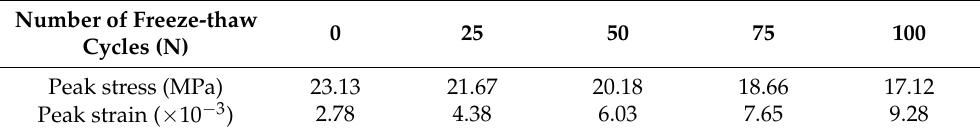
Table 4. Compressive stress and strain values of concrete under freeze-thaw cycles (salt freezing). Number of Freeze-thaw 0 25 Cycles (N) Peak stress